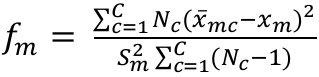
Figure 4. The scores plot of PC2 versus PC1 for the peak table of FTIR spectra obtained from cultivated and uncultivated peat at 0–20 cm